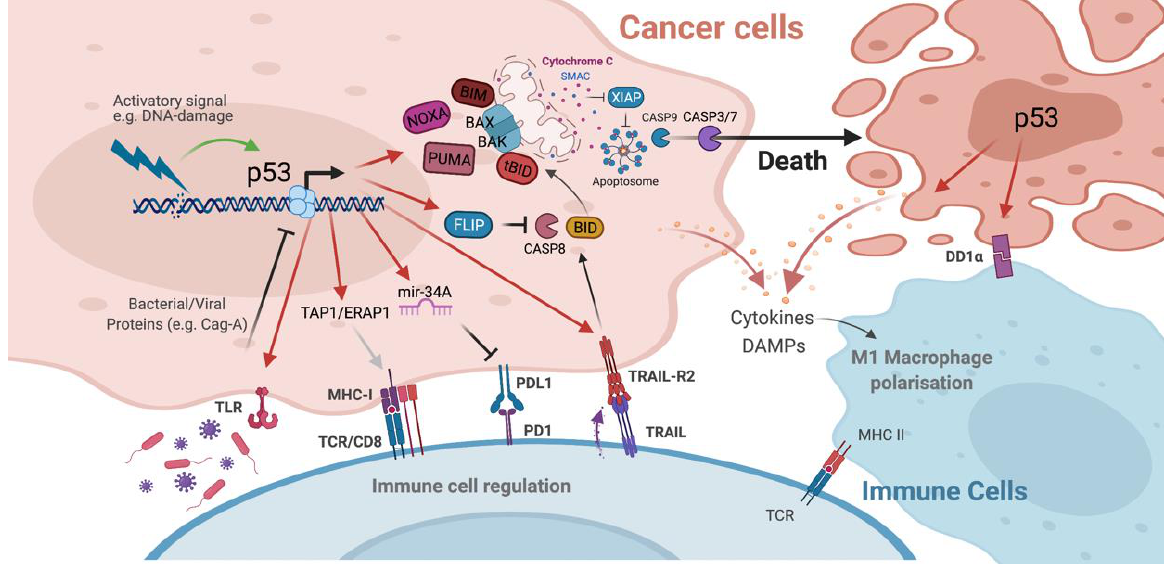
Figure 2. p53 regulates cell death and immune responses. Schematic representation of the core proteins and signalling molecules involved in p53-induced cell death and immune cell regulation. Created with BioRender.com (accessed on 12 June 2021) .